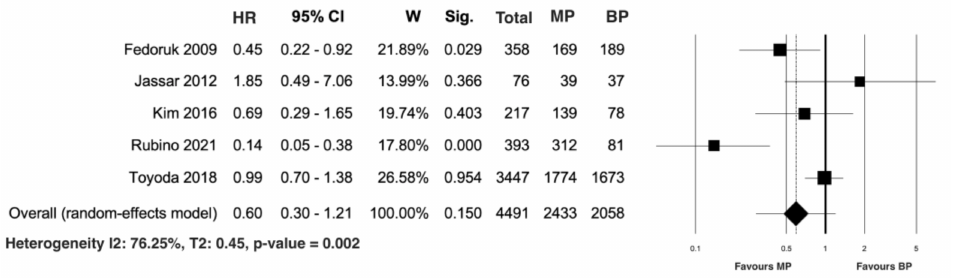
Figure 7. Forest plot for early mortality. No statistical differences were observed between the MP and BP groups. Abbreviations: OR, odd ratio; CI, confidence interval; W, weight; MP, mechanical prosthesis; and BP, biological prosthesis.